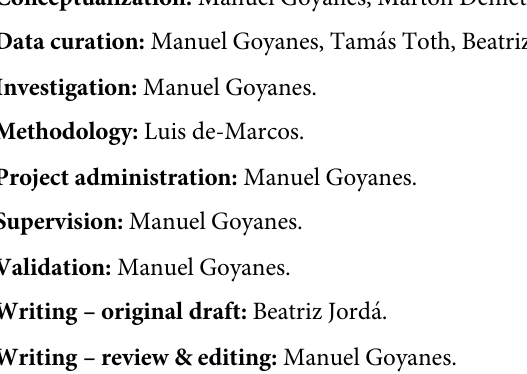
S1 Fig. Labeled graph of the social network of journals and EBs. The labeled graph of the social network of journals and members is provided as high-resolution image (png) and vector image